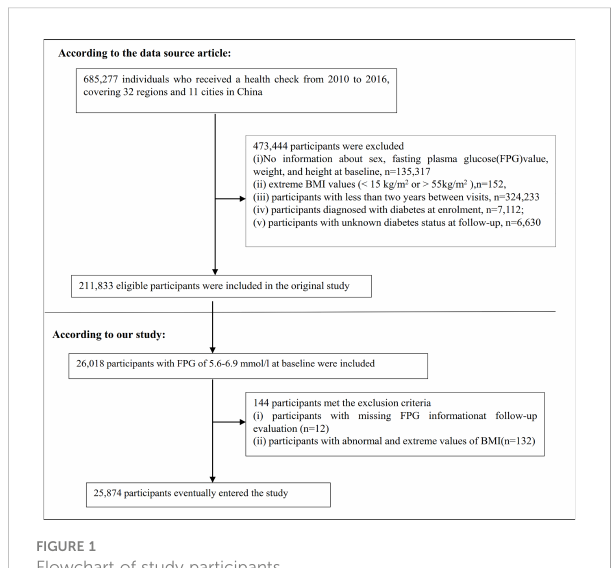
FIGURE 1 Flowchart of study